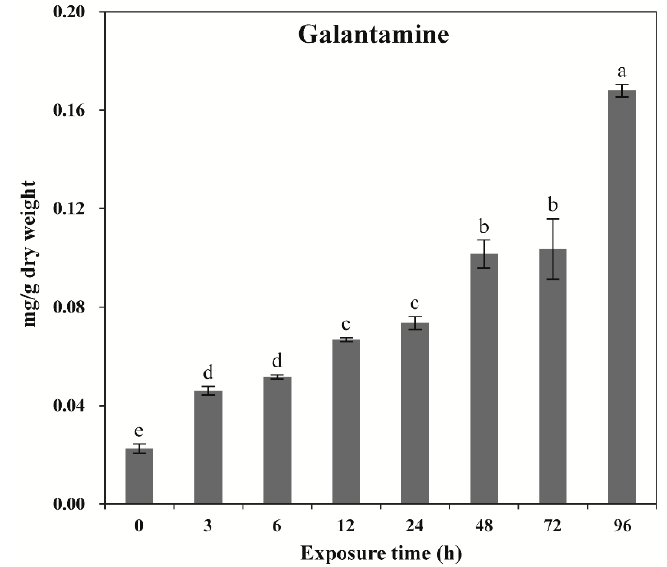
Figure3. Galantaminecontentatdi ff erenttimepointsafterexposuretowoundingstress. Di ff erentletters Figure 3. Galantamine content at different time points after exposure to wounding stress. Different indicate a significant di ff erence at p < letters indicate a significant difference at p < 0.05.